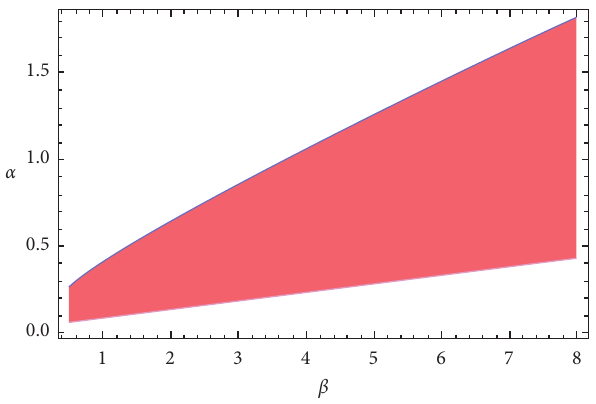
Figure 1: Joint confidence region for β and α . Table 5: MSE of MLEs and BEs with true